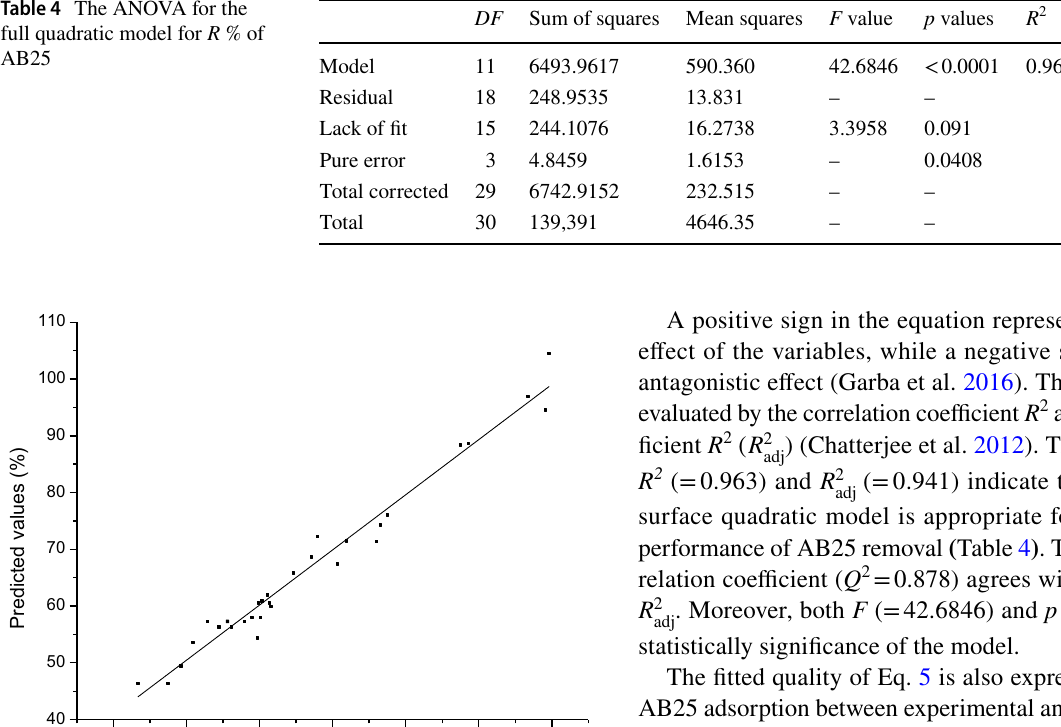
Table 4 The ANOVA for the full quadratic model for R % of